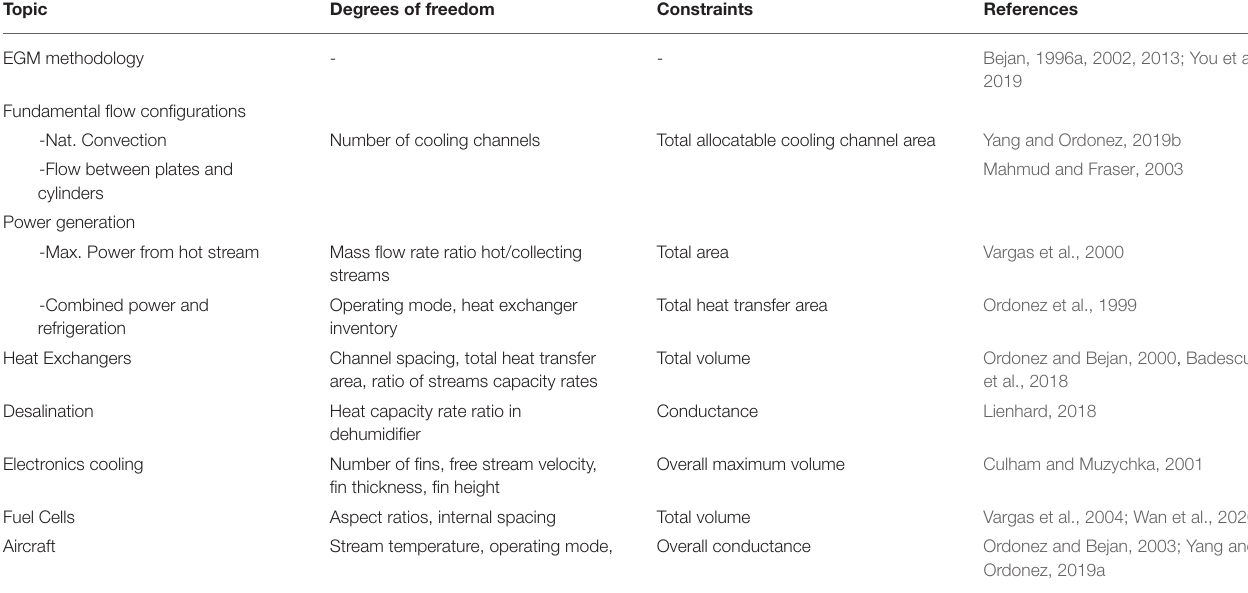
TABLE 1 | Examples of entropy generation minimization and thermodynamic